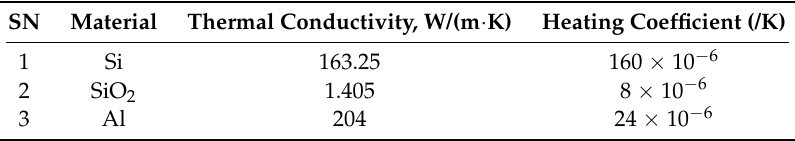
Table 2. Physical properties of the waveguide and heater